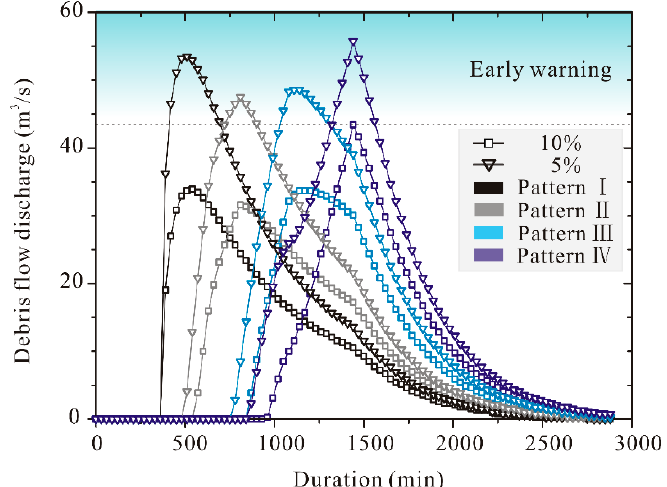
Figure 10. Discharge (under consideration of blocking while D c = 1.5) of B-B’ under the conditions of di ff erent rainfall patterns; square represents the debris flow discharge induced by rainfall at the frequency of 10%; inverted triangle represents the debris flow discharge induced by rainfall at the frequency of 5%; dash / dot line represents the critical discharge on